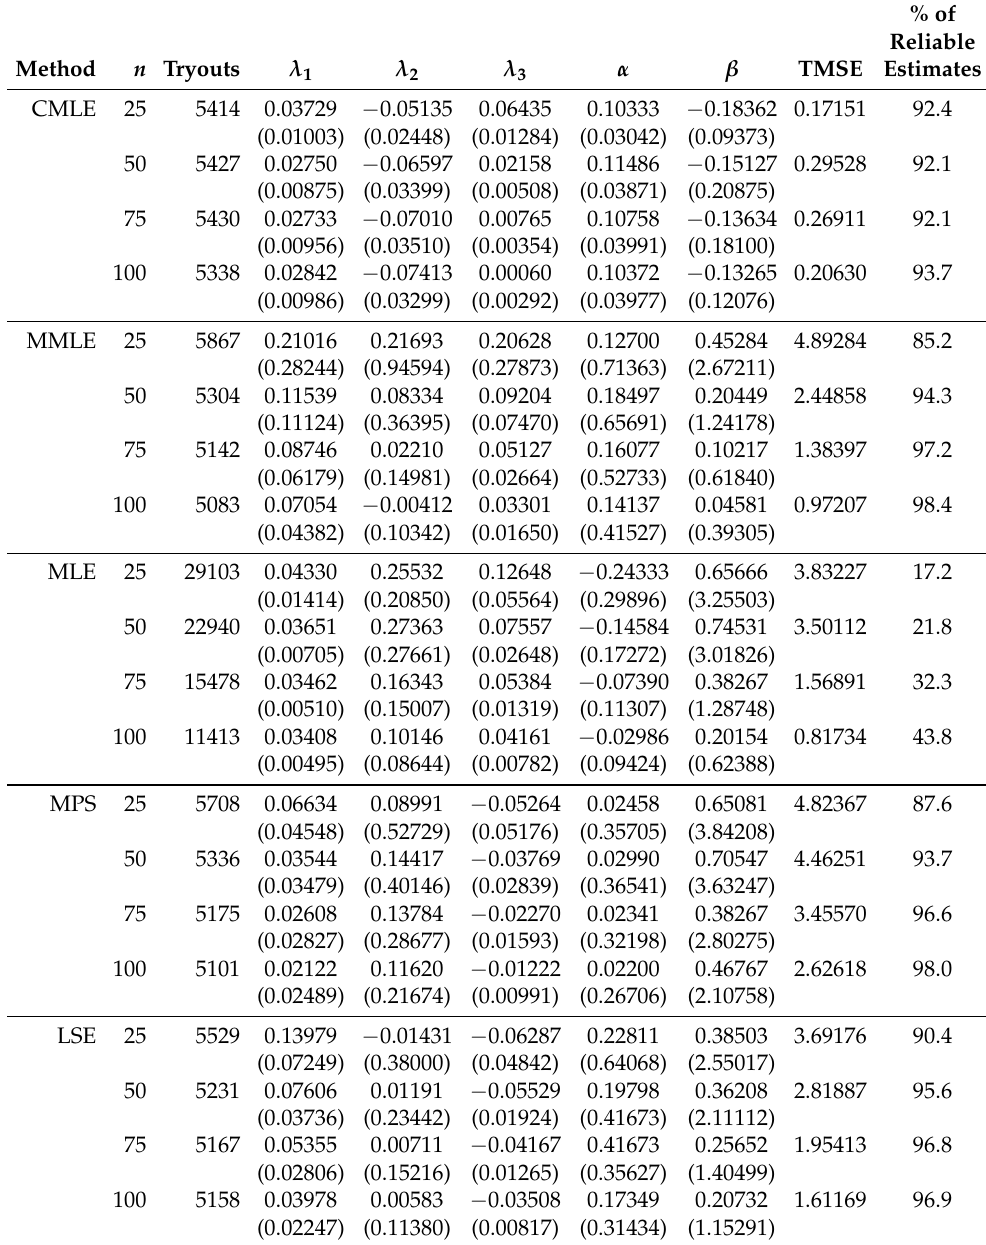
Table 3. Simulated biases and MSEs (in parentheses) of the parameter estimates obtained based